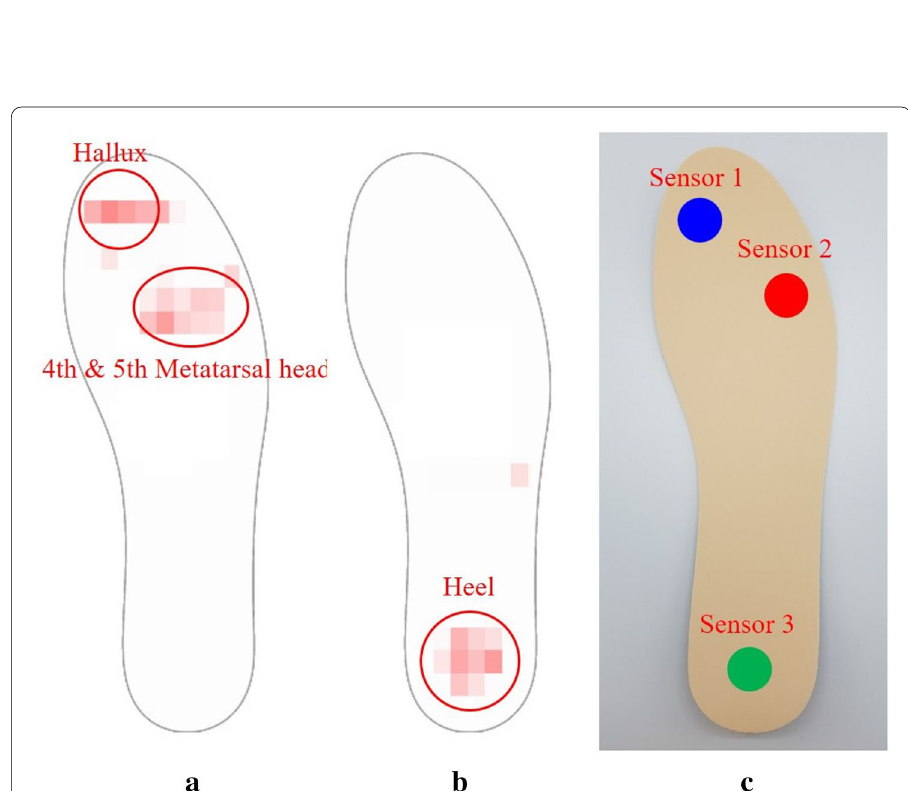
Fig. 2 Plantar pressure distribution. a Pedal pressed. b Pedal released. c Sensor